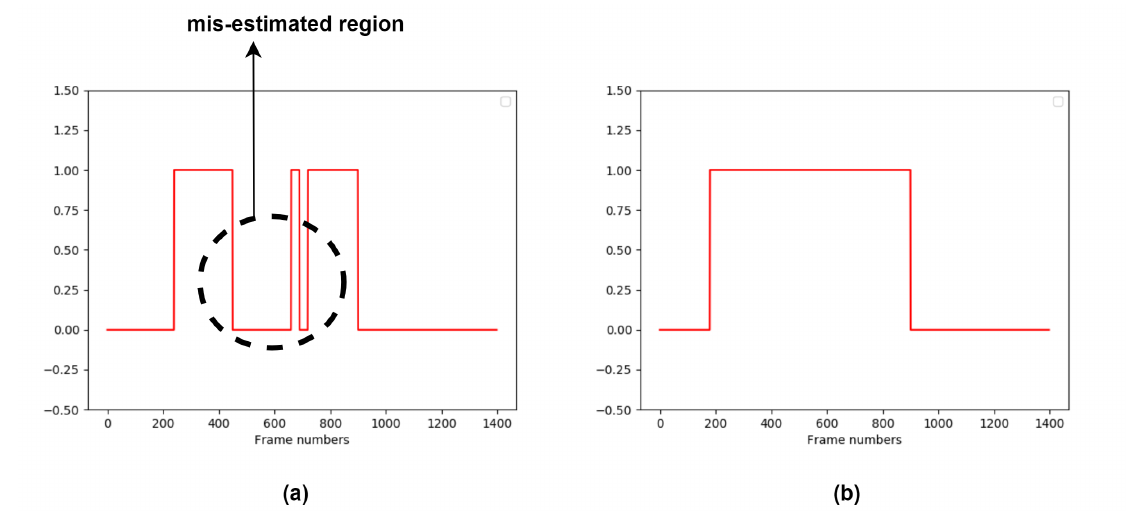
Figure 8. Temporal location of hand-hygiene temporal ( a ) produced by the first system stage ( b ) and final searched region. Each plot shows the confidence score of deciding “hand hygiene” or not as a function of the number of frames. The dashed circle indicates the region that is misidentified by the wall coarse